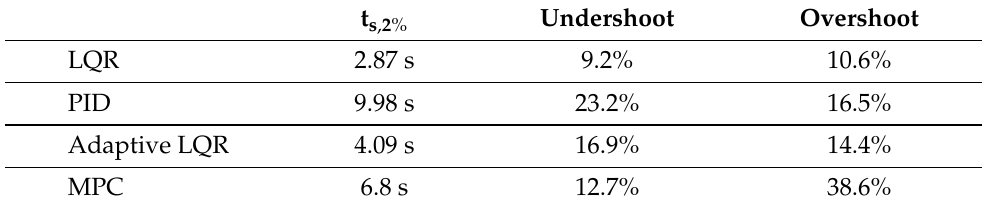
Table 12. Comparison among all the tested controllers: recovering from a disturbed